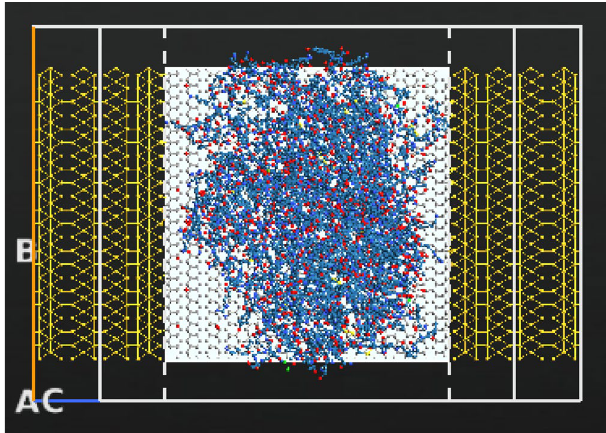
Figure 5. Top view of the designed biosensor with Cu MNPs, COVID-19 antibody and COVID-19 spike protein. Produced by QuantumATK software (version 2018.06).